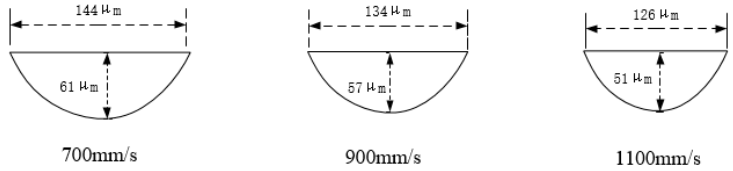
Figure 8. The geometry of a single molten pool at different scanning speeds.